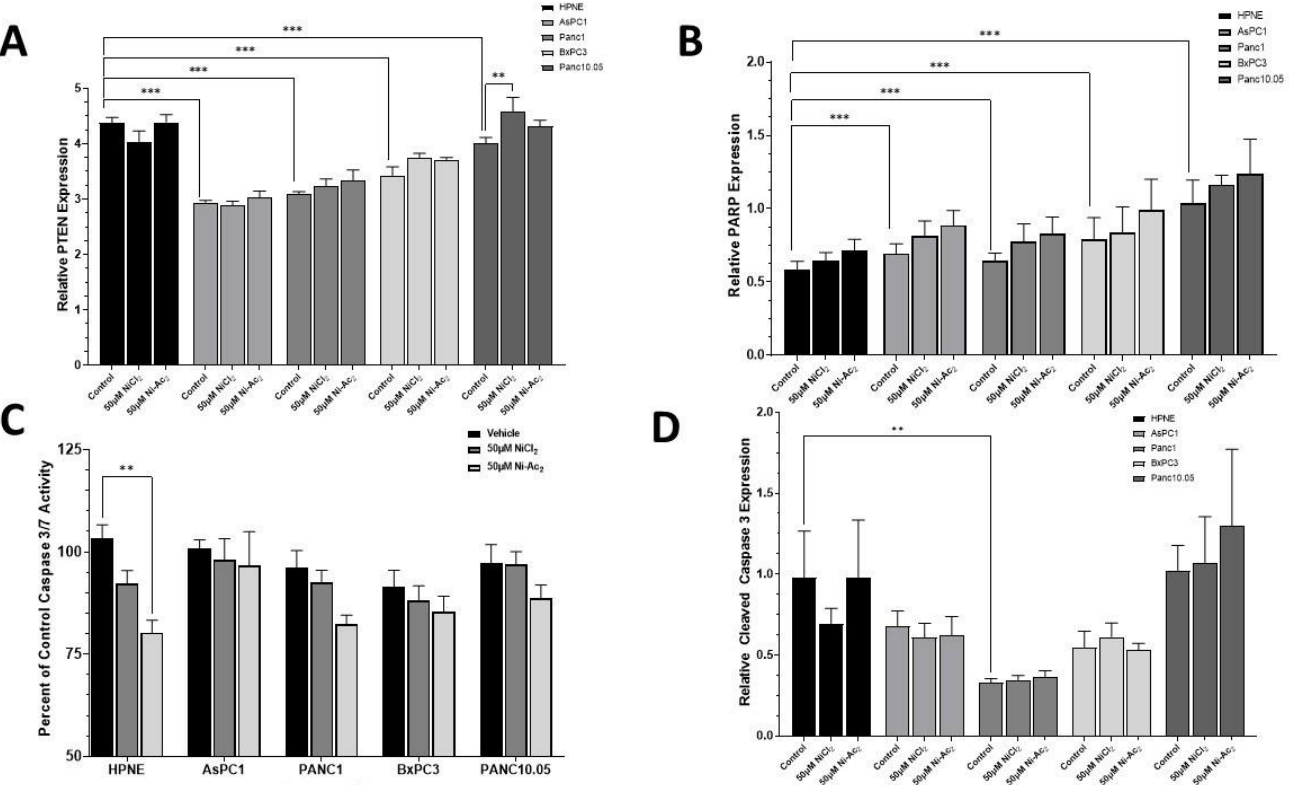
Figure 6. Quantification and expression of key cell-function proteins after 48 h exposure to 50 µ M NiCl 2 or Ni-acetate in PDAC cell lines. These assays quantified the amount of PTEN ( A ), PARP ( B ), caspase 3/7 activity ( C ), and cleaved (active) caspase 3 expression ( D ). The major difference observed between groups was dependent on the cell line, with each of the PDAC cell lines expressing different protein levels. Treatment effects were evident in PTEN expression in the Panc-10.05 cell line, in which NiCl 2 exposure resulted in a significant ( p < 0.01) increase in PTEN expression. Caspase 3/7 activity was significantly ( p < 0.01) reduced after exposure to Ni-acetate. Data are expressed as the mean ±SD of four (protein expression) or eight (caspase 3/7 activity) assays performed in duplicate (** p < 0.01; *** p < 0.001).